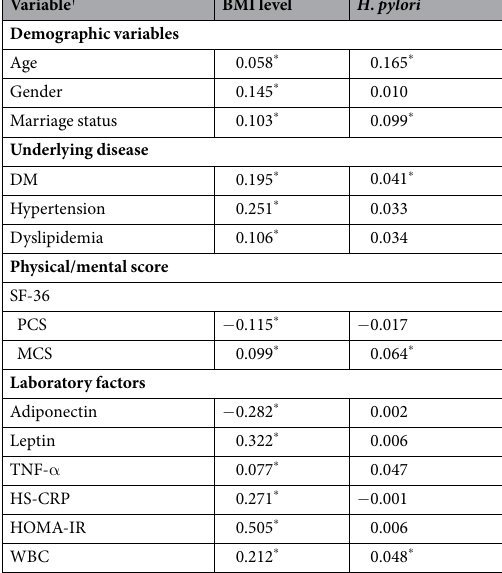
Table 2. Correlation between multivariable, BMI or H . pylori infection. Phi coefficient analysis for category data ( H . pylori , gender, DM, HTN, dyslipidemia) and Spearman’s coefficient rho for rank correlation (BMI level) and Pearson’s correlation coefficient for continuous data (age, PCS, MCS, HS-CRP, TNF- α , adiponectin, leptin, HOMA-IR, WBC). * P < 0.05.